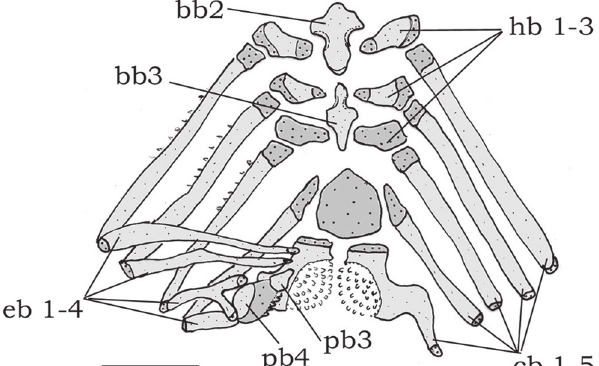
Fig. 5. Pharyngeal arches of Centromochlus britskii , MZUSP 43251, paratype, 35.9 mm SL. Dorsal view.